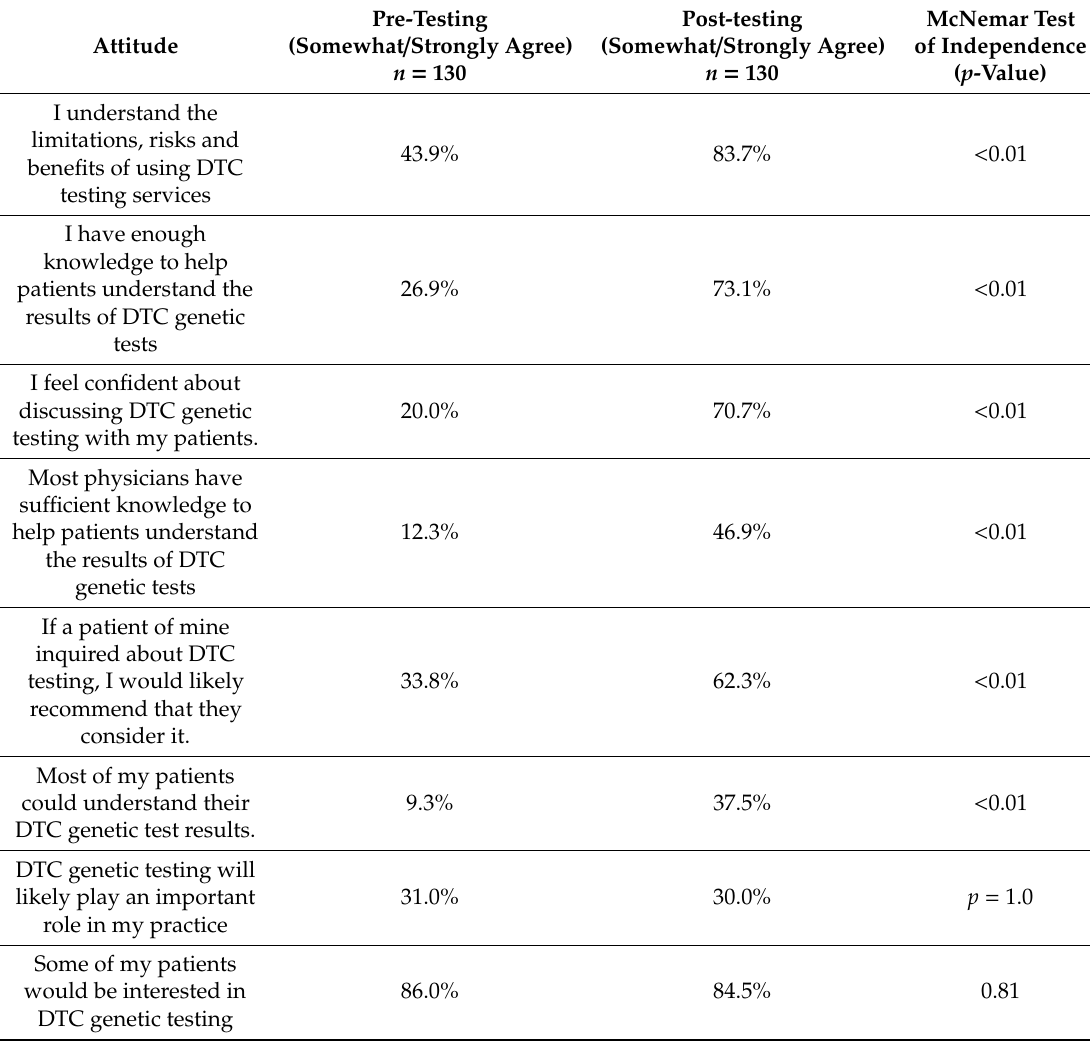
Table 3. Percentage of responses in agreement (strongly or somewhat agree) with statements about